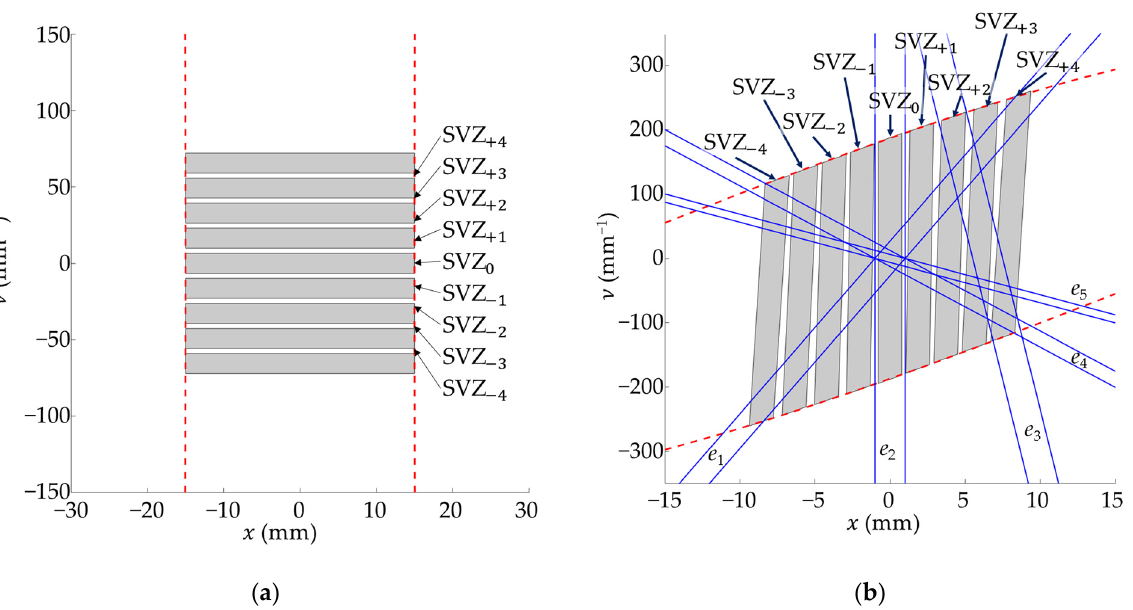
Figure 5. Wigner distribution function (WDF) analysis of the proposed system. ( a ) WDF of each SVZ on the DMD plane; ( b ) propagated WDF at the viewing distance.